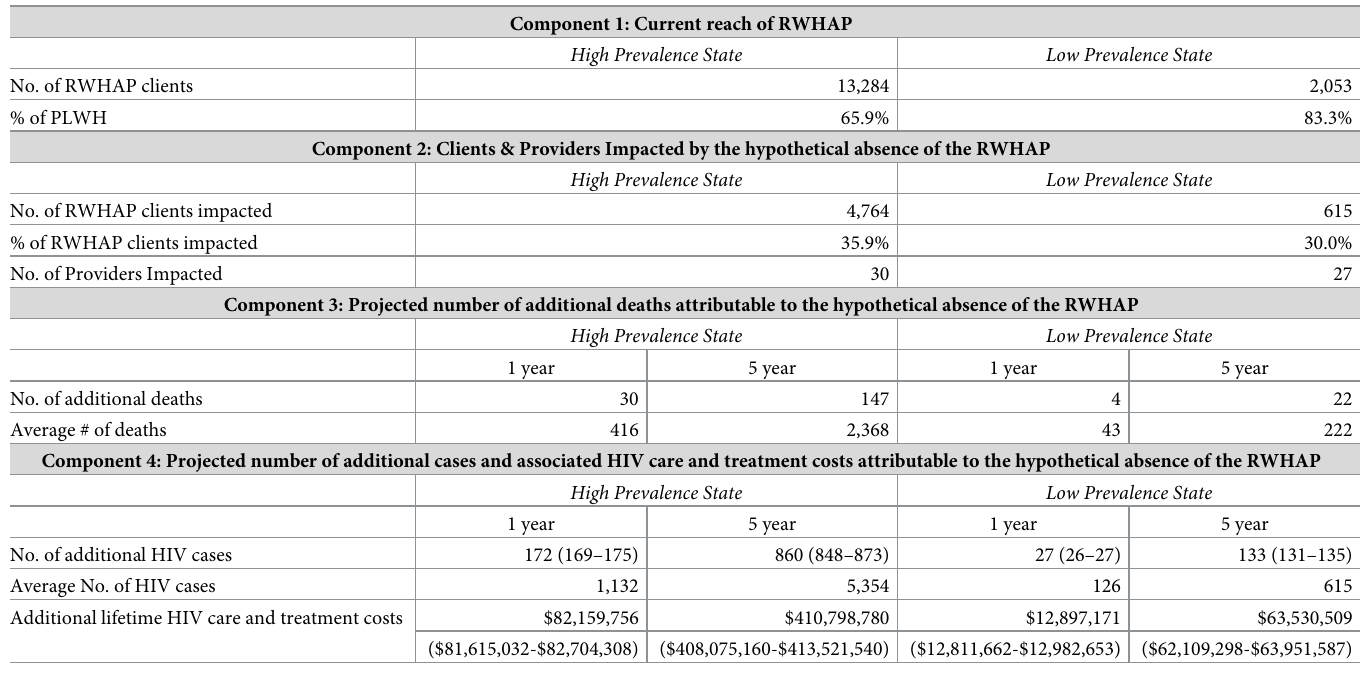
Table 2. Results of state-specific impact model in two example states (high and low